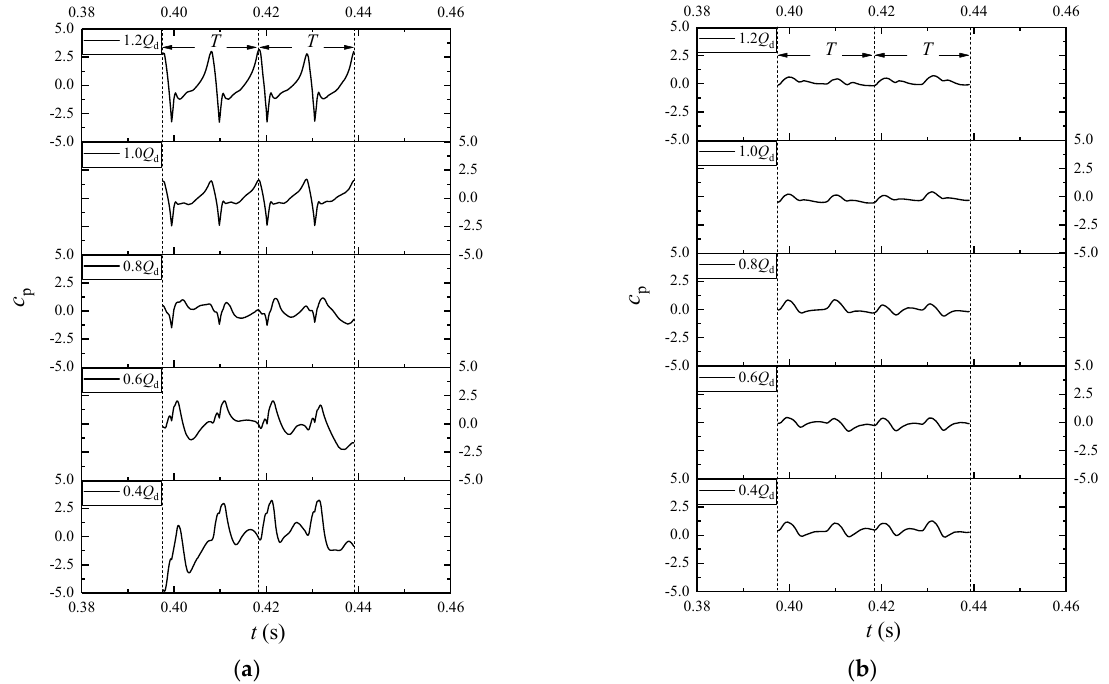
Figure 9. Pressure pulsations of volute at different flow rates: ( a ) pressure pulsation at P2; ( b ) pressure pulsation at P7. Frequency spectra of pressure pulsations at the volute under different flow rates are shown in Figure 10. It is presented that the domain frequencies of the pressure pulsation under different flow rates are the blade passing frequency (St = 1) and its multipliers (St = 2, 3, 4 and etc.). At 1.2 Q d , the amplitude of pressure pulsation at the blade passing fre ‐ quency is larger when the interaction occurs in the vicinity of the tongue at P2. However, at P7, the high amplitude of pressure pulsation occurs at a low flow rate (0.4 Q d ). In addi ‐ tion, especially at P2, it is noted that the broadband pulsation occurs at 0.4 Q d , which means some unsteady flow structures could be generated at this area, e.g., vortex, back ‐ flow and flow separation. This is clearly shown in Figure 11, where the backflow phe ‐ nomena are presented in the outlet of impeller, and some vortices are produced near the suction side of the blade. Actually, the flow fields at t 0 and t 2 are quite similar, and the flow field at t 1 is quite similar to that at t 3 , thanks to the effect of the relative position of blade to tongue of vol ‐ ute. Instantaneous fields of vorticity magnitude at the low flow rate are illustrated in Figure 11c. The vorticity magnitude Ω was calculated according to the definition of the new omega vortex [27]. High vorticity magnitude is occurred in the vicinities of the blade trailing edge and tongue of volute, due to the rotor ‐ stator interaction between impeller and volute. The vorticity magnitude layer on the suction side of the blade shows the flow separation. Figure 12 shows the flow velocity streamlines of the pump under different flow rates. It can be found that the flow separation is weakened as the flow rate increases. At 1.0 Q d and 1.2 Q d , there is no vortex inside the pump. It is clear evidence to support the low ‐ pressure pulsation under the designed flow rate.